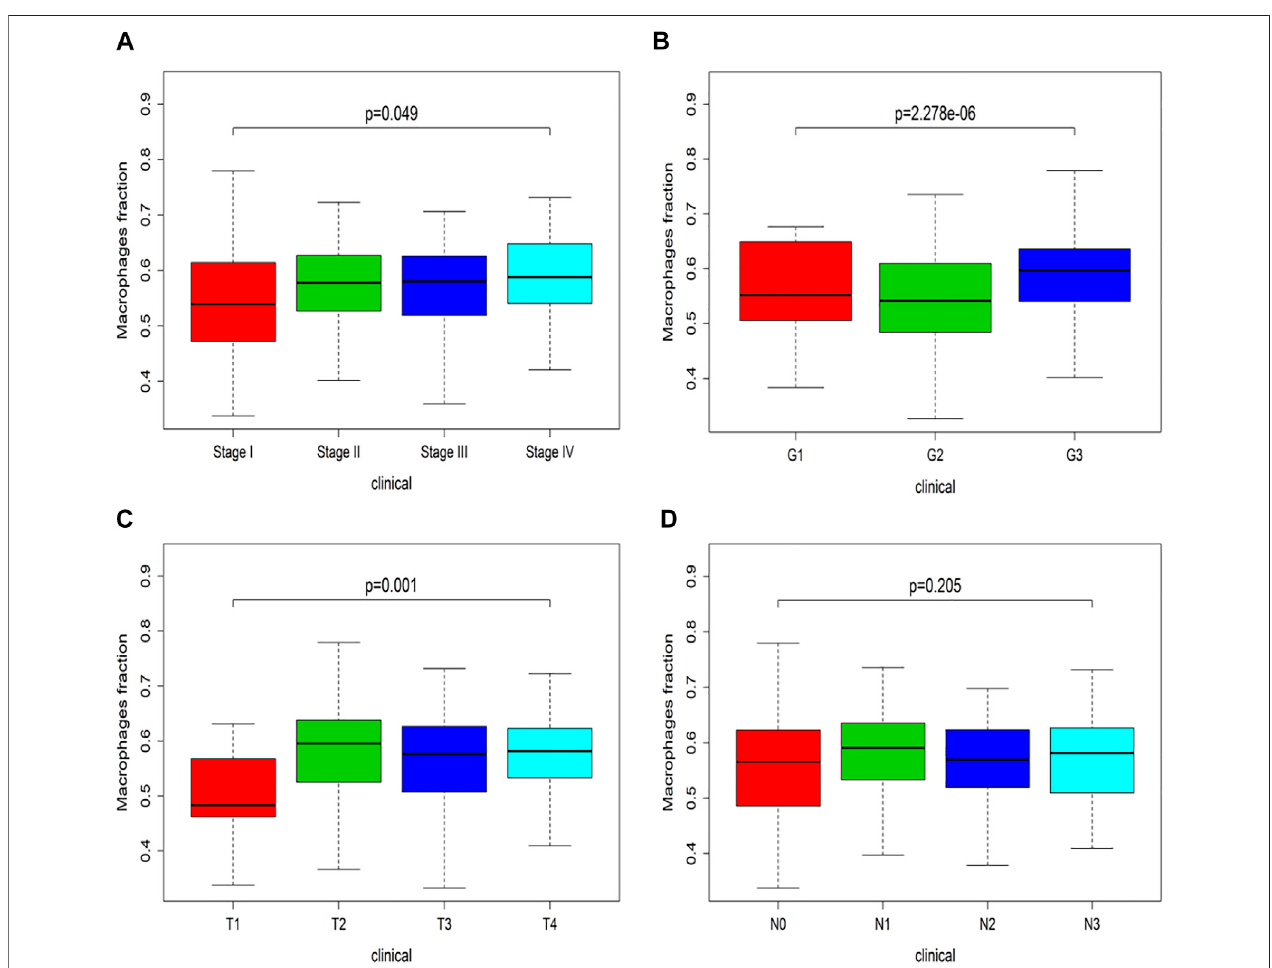
FIGURE3| Clinical stageofmacrophageinTCGA. (A) Macrophagefraction inthe I-IVstage. (B) Macrophage fraction inG1-G3 grade. (C) Macrophage fraction in the T1-T4 stage. (D) Macrophage fraction in N0-N3 stage.